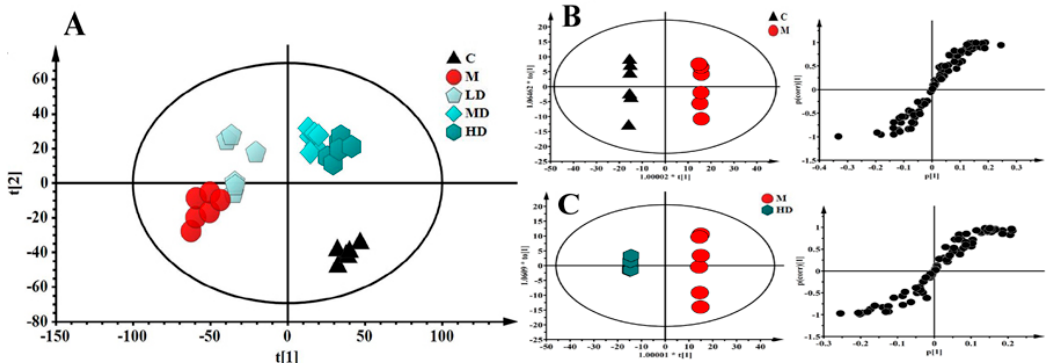
Figure 3. Multivariate analysis based on the UPLC-MS profiling data in positive ion mode ( n = 6). ( A ): PCA analysis of all groups. Score plot of PCA ( R 2 X = 0.665, Q 2 (cum) = 0.570; ( B ): OPLS-DA of control and corticosterone-treated group. Score plot of OPLS-DA ( R 2 X = 0.964, R 2 Y = 0.904, Q 2 (cum) = 0.854); ( C ): OPLS-DA of corticosterone-treated and high dose CR-50E-treated group. Score plot of OPLS-DA ( R 2 X = 0.834, R 2 Y = 0.951, Q 2 (cum) = 0.731). C: control group; M: corticosterone-treated